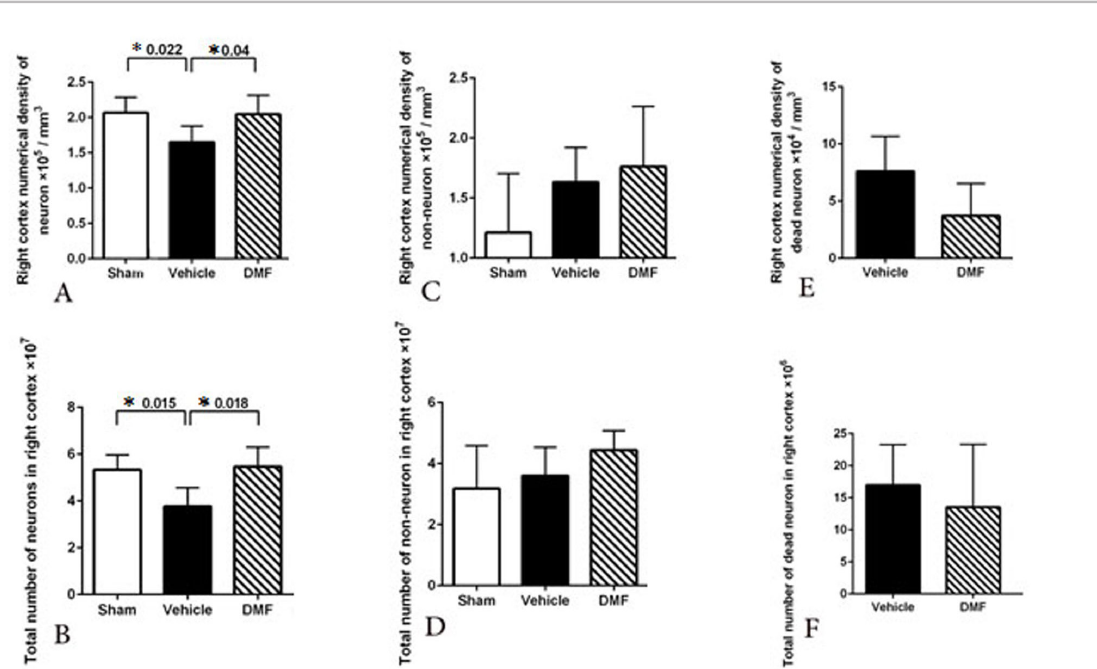
FIGURE 6 - The numerical density and the total number of neurons, non-neurons, and dead neurons (mean ± SD) in the sham, vehicle, and dimethyl fumarate (DMF) –treated groups. * P<0.05